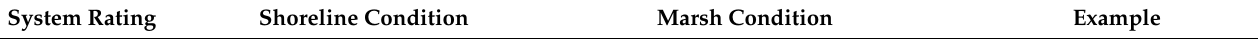
Table 2. Objective marsh classification scheme for categorization as healthy, eroded, or severely eroded.